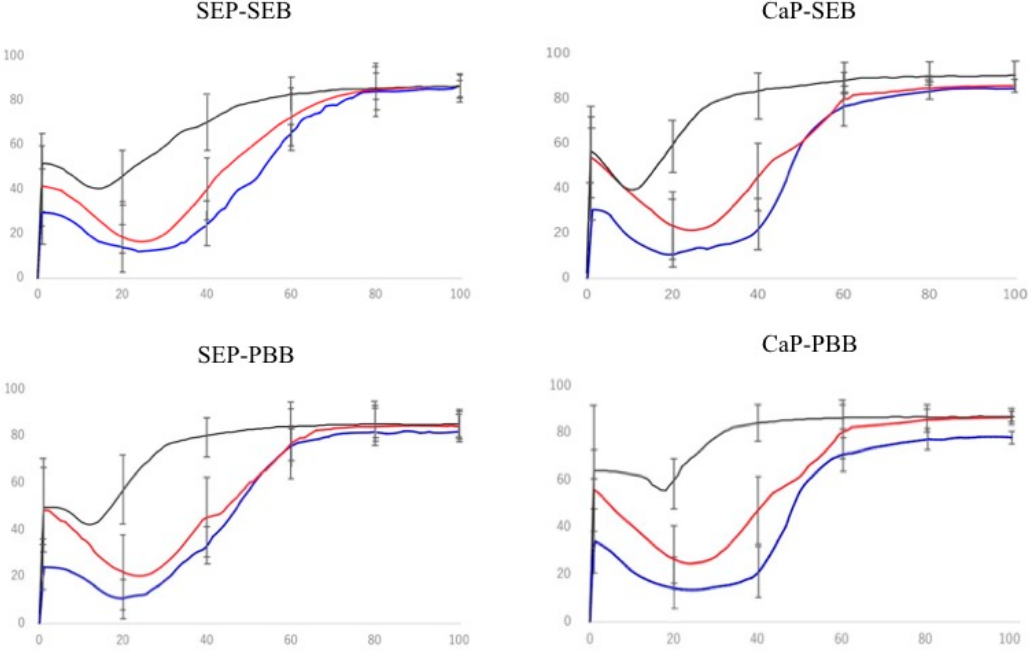
Figure 3. Average curve of mineral loss ( Δ Z). X axis is µm. Y axis is Vol%. Table 2. The mean value of mineral loss values ∆ Z (vol%. µ m) at the 3 time points. Identical superscript letters indicate significant di ff erences within each treatment period. ( p ≤ 0.05). Group